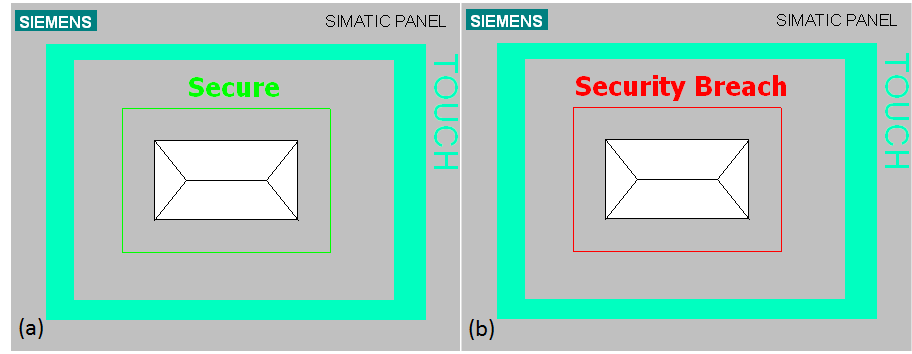
Figure 6. A simple HMI display for ( a ) a secure perimeter and ( b ) a security